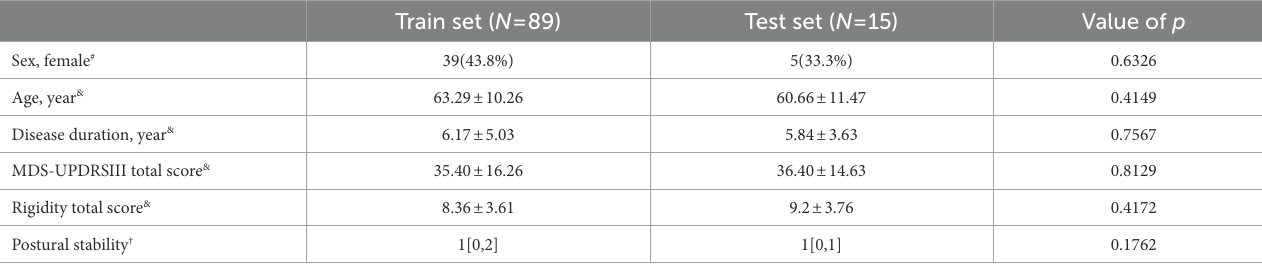
TABLE 1 Demographic data of this study.